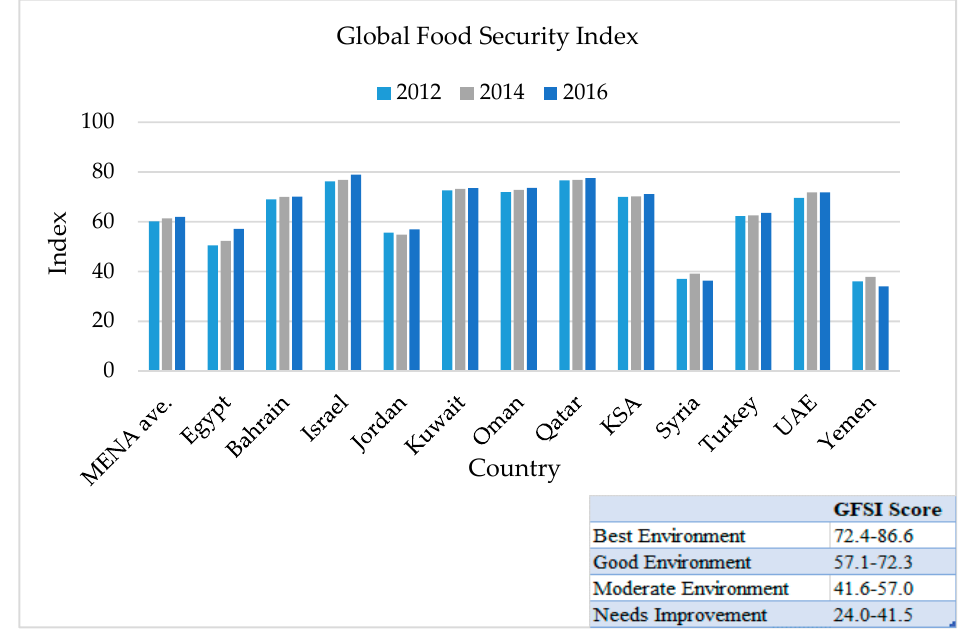
Figure 2. Global Food Security Index (0–100, 100 = ideal environment). Note: the countries not listed means the GFSI was not provided by the source for these countries due to data unavailability. The data is acquired from [40–42].